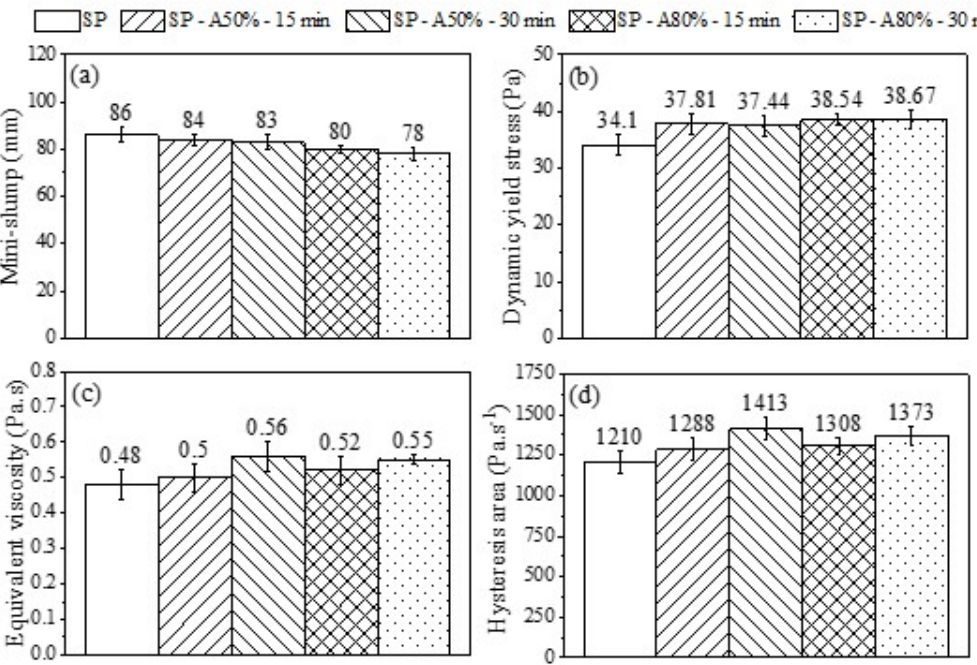
Figure 7. Fresh-state properties of the pastes at 10 minutes of hydration: mini-slump (a); dynamic yield stress (b); equivalent viscosity (c); and hysteresis area (d). Note: error bars in (a) correspond to ±1 standard deviation, while in (b)-(d) were estimated based on complementary